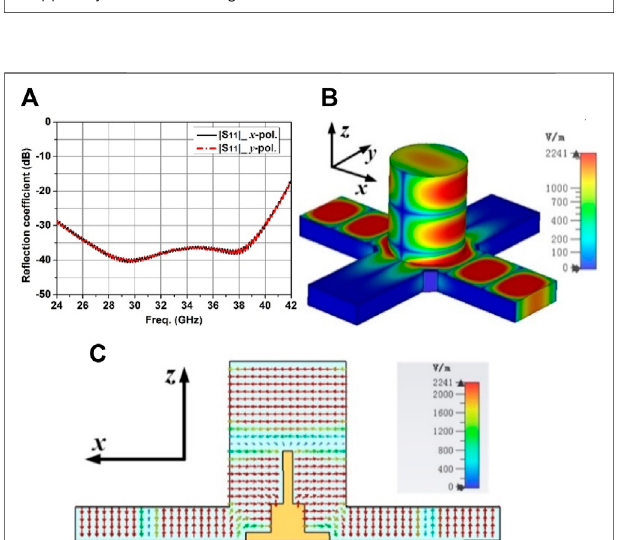
(C) Sectionviewofthe E - fi elddistribution(35 GHz)insidetheturnstilejunction.